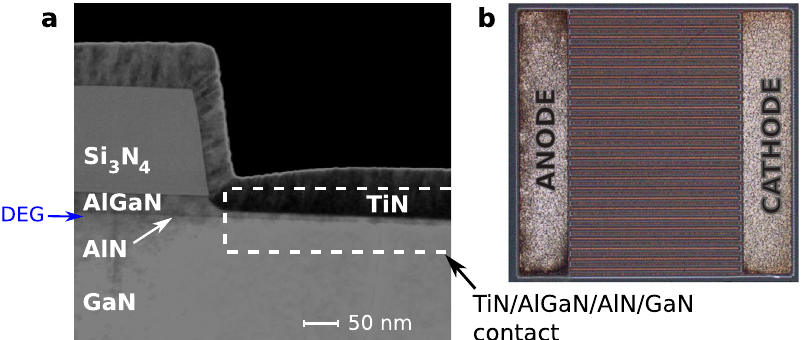
Figure 3. Fabricated heterojunction diode. ( a ) TEM close view around the anode contact found on a III-N heterojunction diode fabricated at CEA-LETI. Dashed box : TiN/AlGaN/AlN/GaN contact. ( b ) Upper view of the power diode showing the interdigitated designed